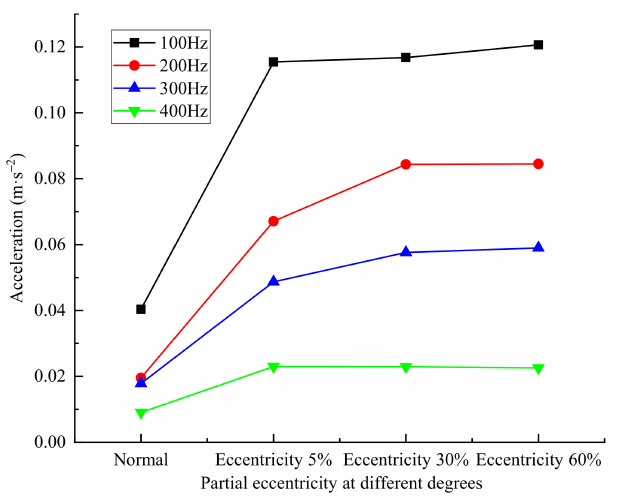
Figure 16. Amplitude change of eccentric acceleration in different degrees at the first 400